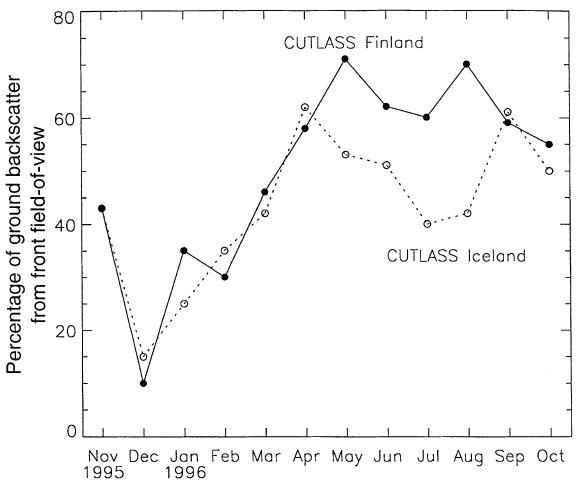
Fig. 8. The monthly variation in the percentage of ground backscat- ter originating in the front fields-of-view of the CUTLASS